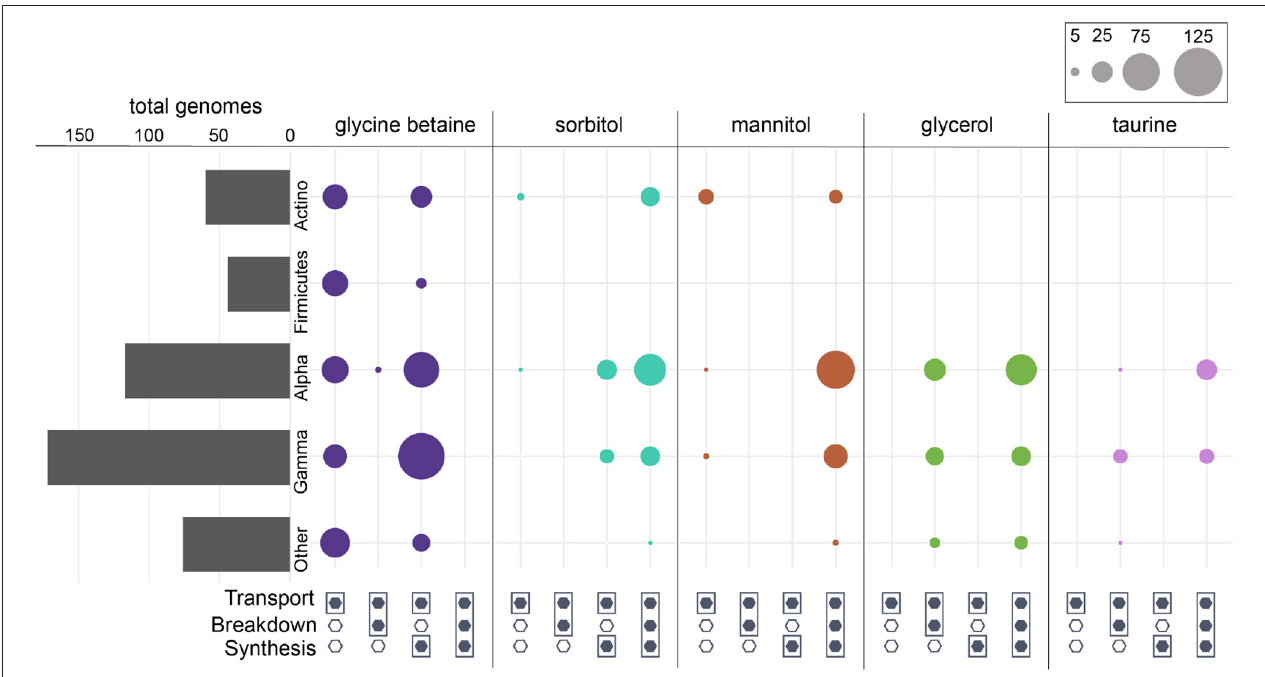
FIGURE 4 | Prokaryotic genomes that contained one or more of the osmolyte ABC transporters annotated in KEGG. Bars represent the total number of genomes that contained at least one transporter. “Other” represents taxa that contributed < 10 % of the total. For each respective osmolyte, circles represent the total number of genomes in each group that were capable of transport only, transport and breakdown, transport and synthesis, or all (transport, breakdown, and synthesis). Missing circles indicate no genomes with the respective category.